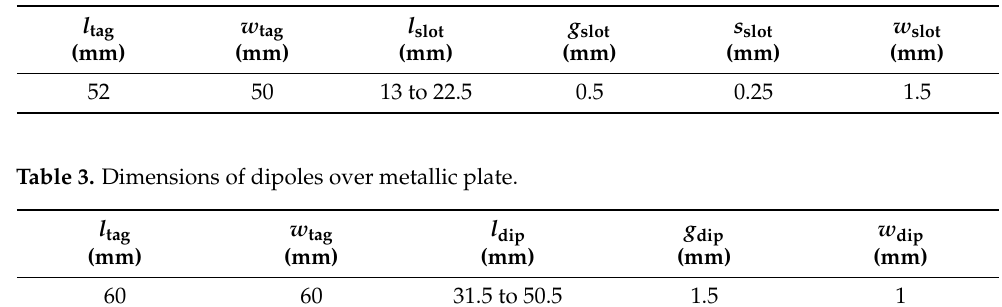
Table 2. Dimensions of U-Slots in the metallic plate.